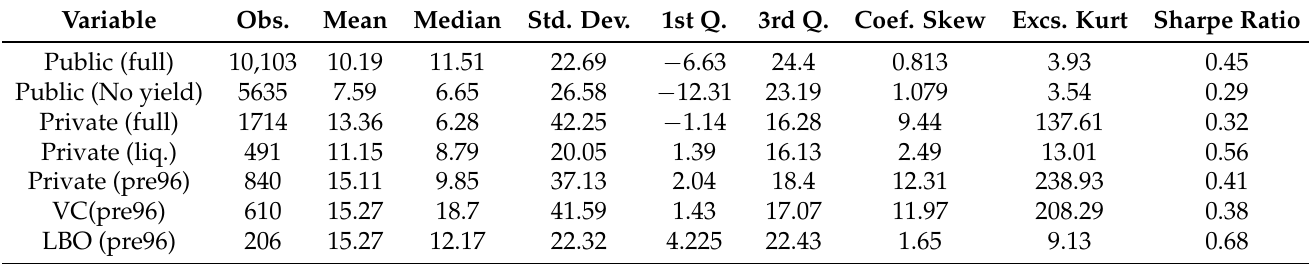
Table 2. Summary statistics of returns of public and private equity funds with different restrictions.